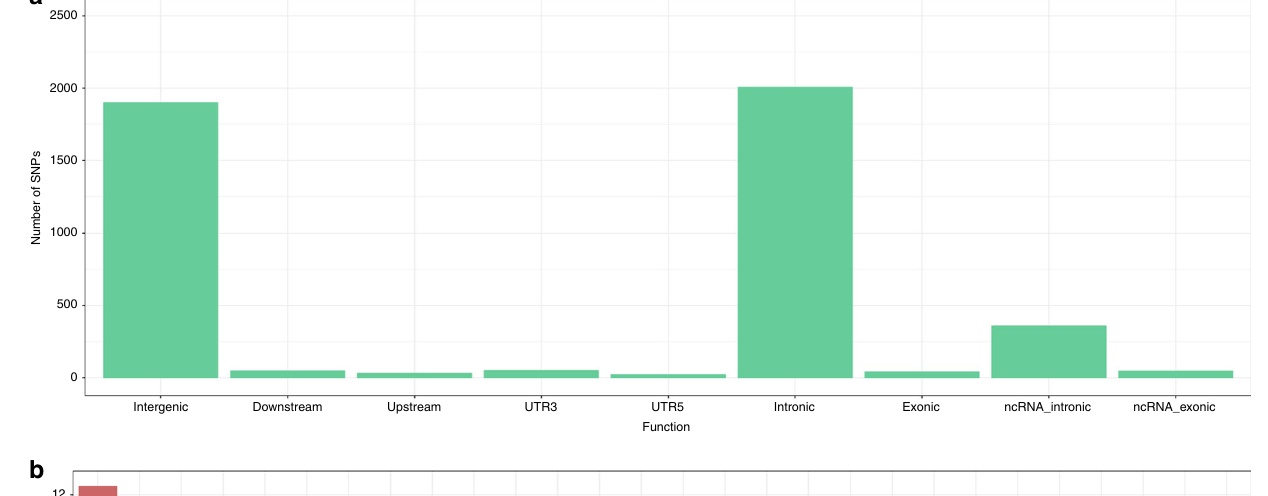
Fig. 5 Functional analyses of reaction time. Analyses include reaction time-associated SNPs, independent signi fi cant SNPs, and all SNPs in LD with independent signi fi cant SNPs. Functional consequences of SNPs on genes ( a ) indicated by functional annotation assigned by ANNOVAR. MAGMA gene- property analysis results; results are shown for average expression of 30 general tissue types ( b ) and 53 speci fi c tissue types ( c ). The dotted line